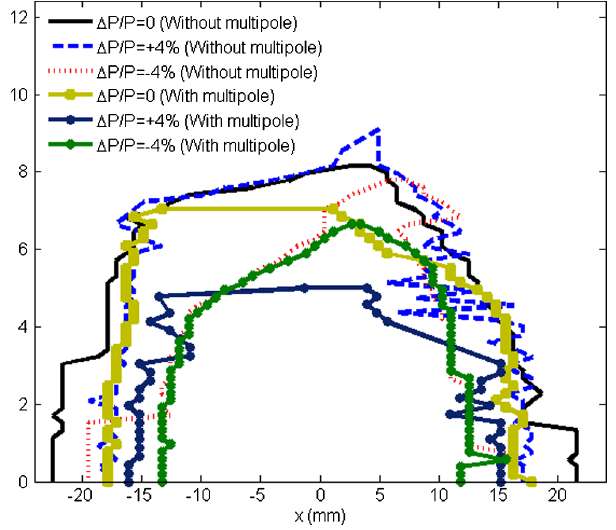
FIG. 8. The dynamic aperture at the center of the straight section. The multipole errors of the magnets are included.